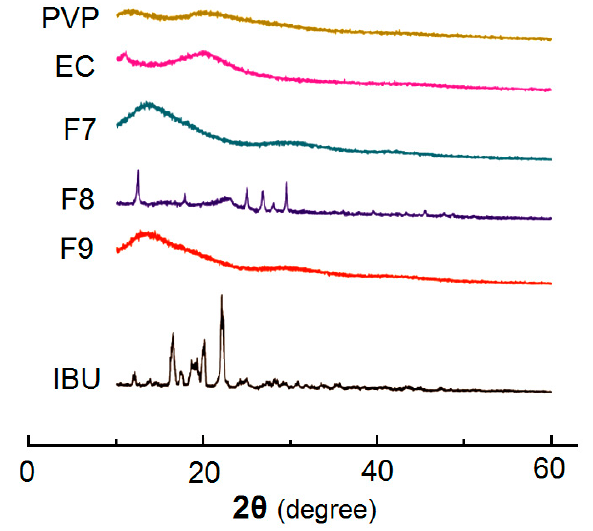
Figure 6. XRD patterns of PVP, EC, IBU and their products F7, F8, and